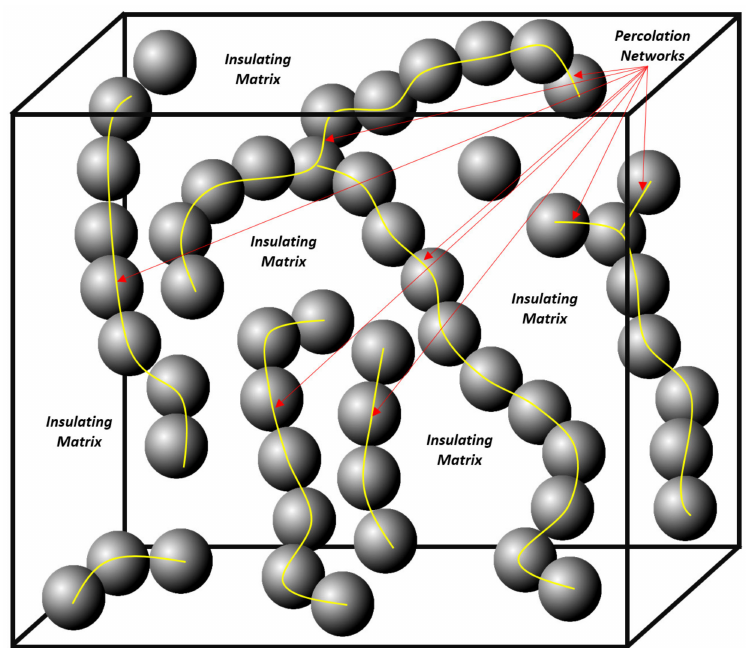
Figure 2. Schematic illustration of percolation networks responsible for charge transport in extrinsic conductive